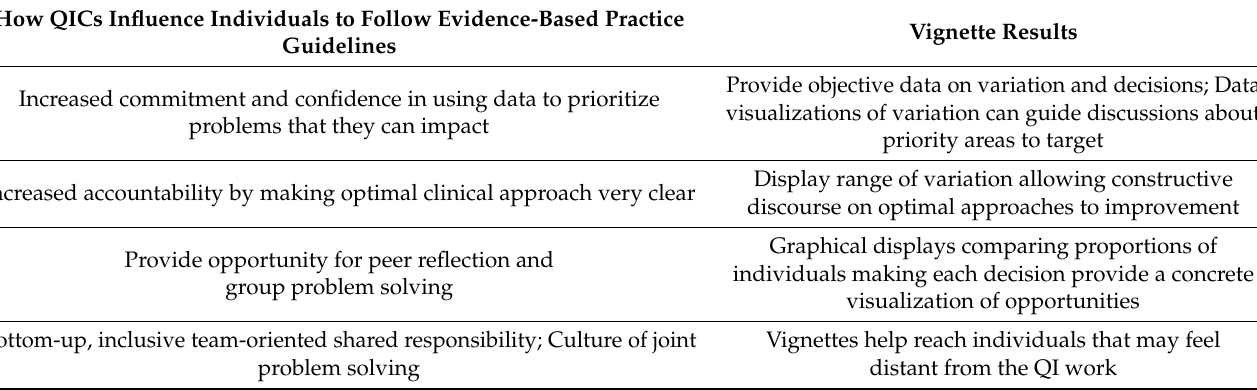
Table 1. Vignette results support QIC mechanisms of influencing